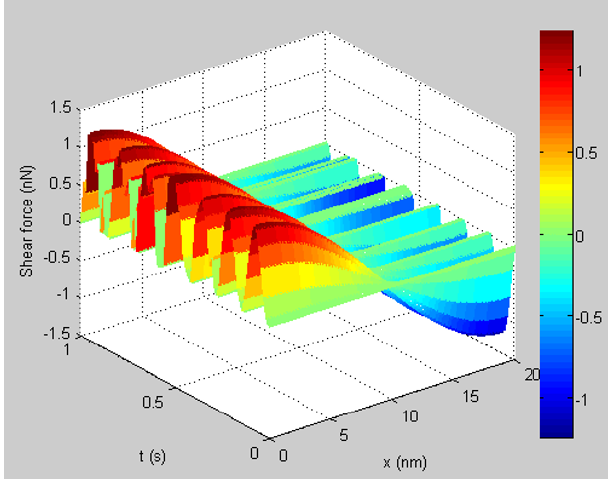
Figure 9. Shear force Diagram of the SWCNT for mode 1